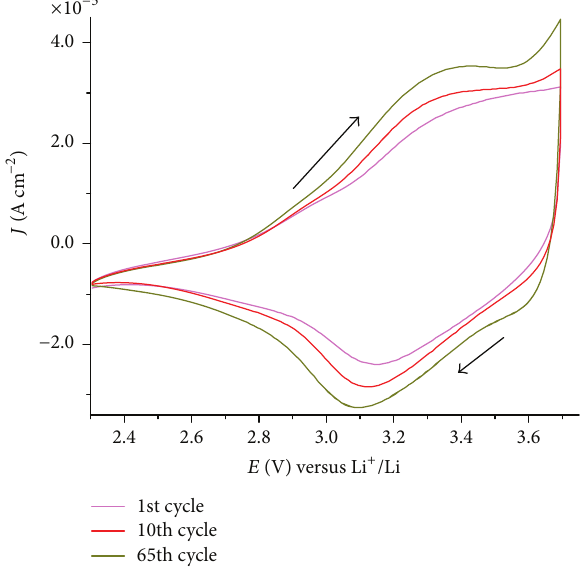
Figure 7: Cyclic voltammograms of RDS NiO ( 𝑙 = 0.3 𝜇 m) spray- x deposited onto ITO. Counter electrode: Li; reference redox couple: Li + /Li; scan rate: 5 mVs −1 . Electrolyte composition as in Figure 1. oxidation is proven by the The activation of the process of NiO x increase of the current density upon repetitive cycling. No further increase of the exchange current is observed after 70 cycles. Arrows indicate the verse of potential